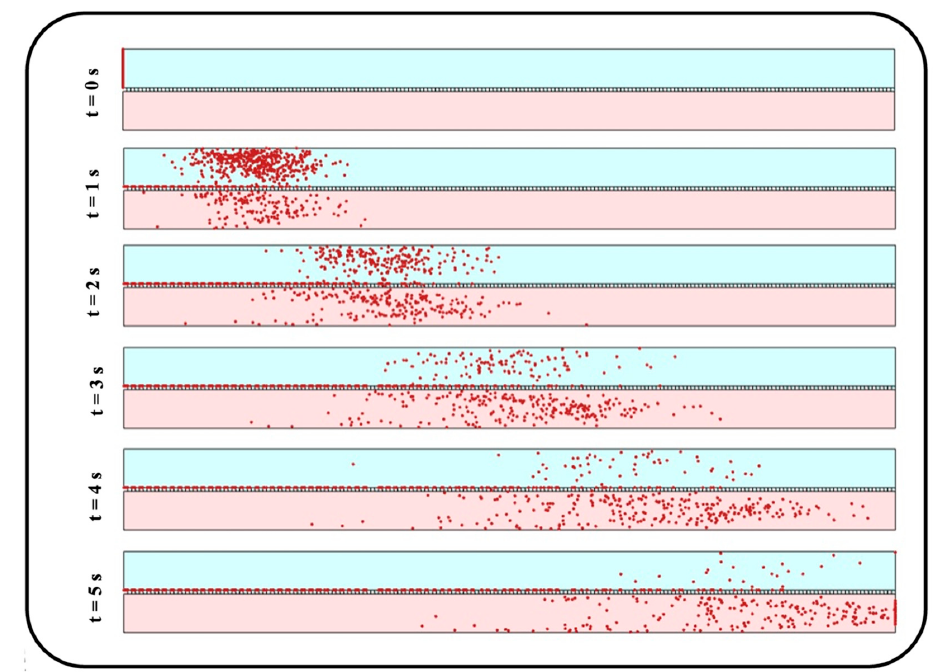
Figure 13. Normalized ( a ) average position and ( b ) standard deviation of transferred NPs of diam- eters ranging from 10 nm to 900 at the outlet of the media channel in the lung-on-a-chip device with different membrane porosities under the fluid velocity of 0.3 mm/s . The solid red line corresponds with an ideal distribution in the media channel.